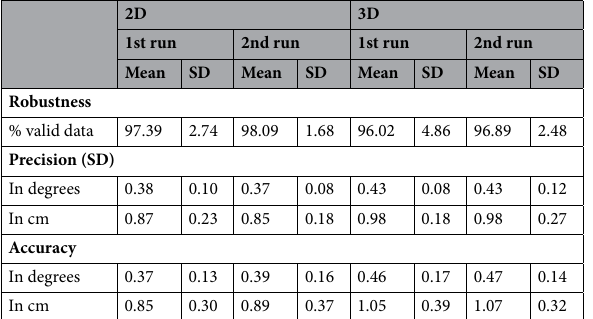
Table 2. Robustness, precision, accuracy for eye tracking on a 2D and 3D face stimulus before and after a 5-minute break. Quality indices were averaged for fixations on eyes, nose, and mouth. Precision (SD) = standard deviation of data samples (Holmqvist et al.,